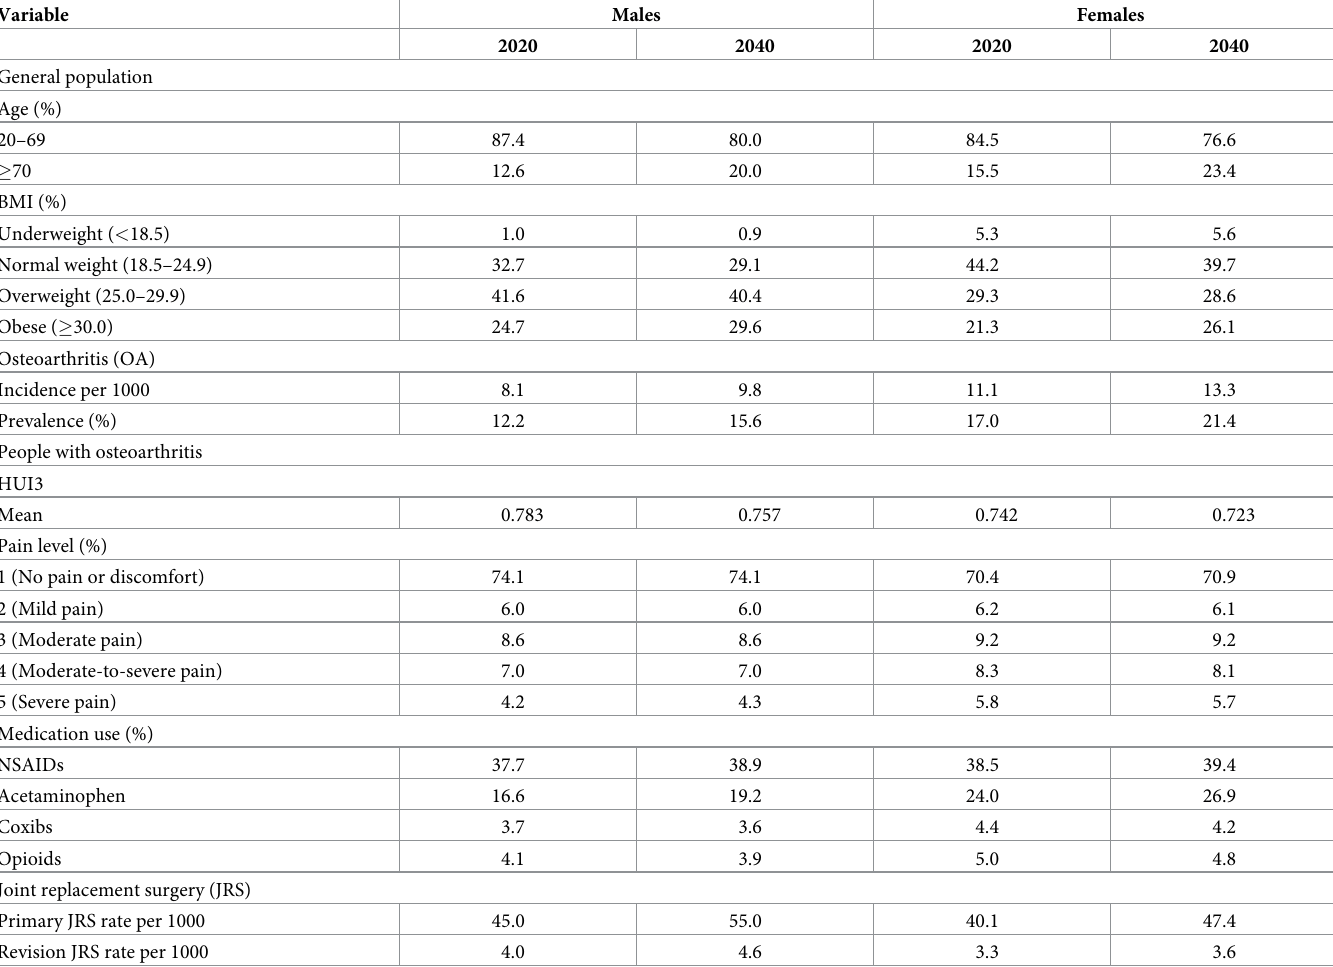
Table 2. Descriptive data for the simulated population (base-case